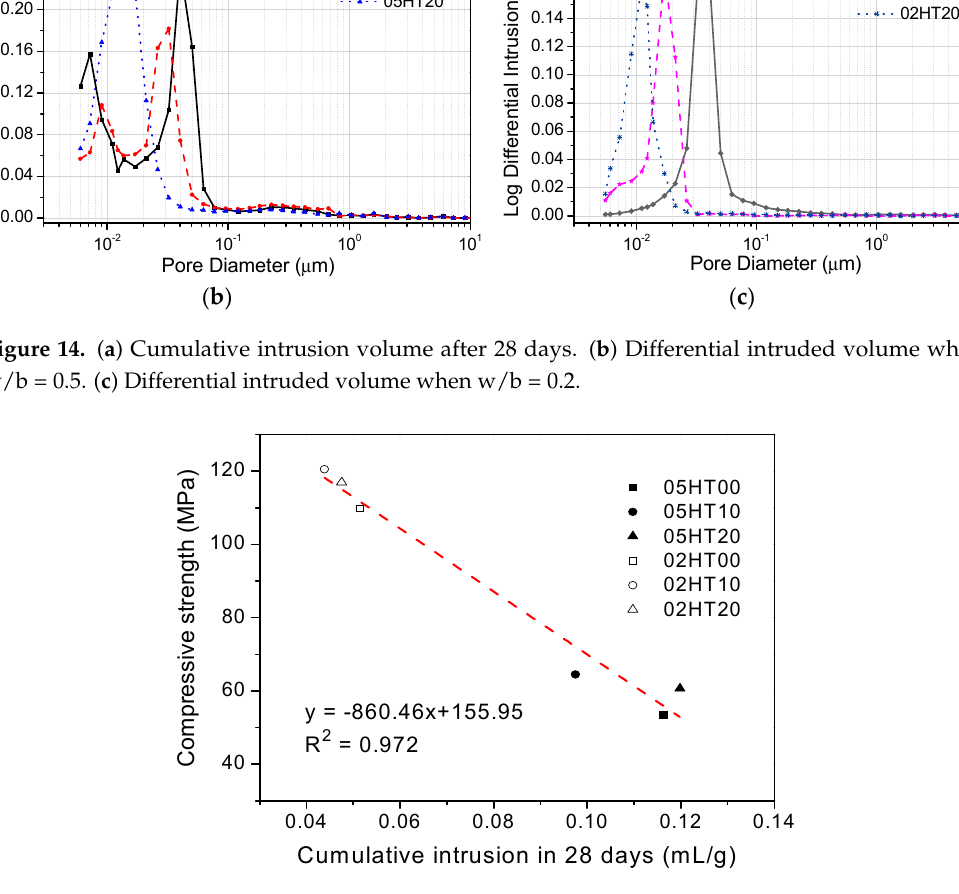
Figure 15. Relationship between compressive strength and cumulative intrusion volume.